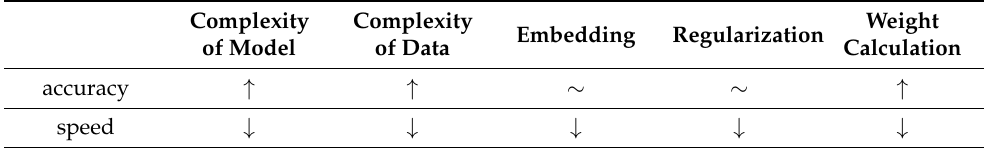
Weight Calculation